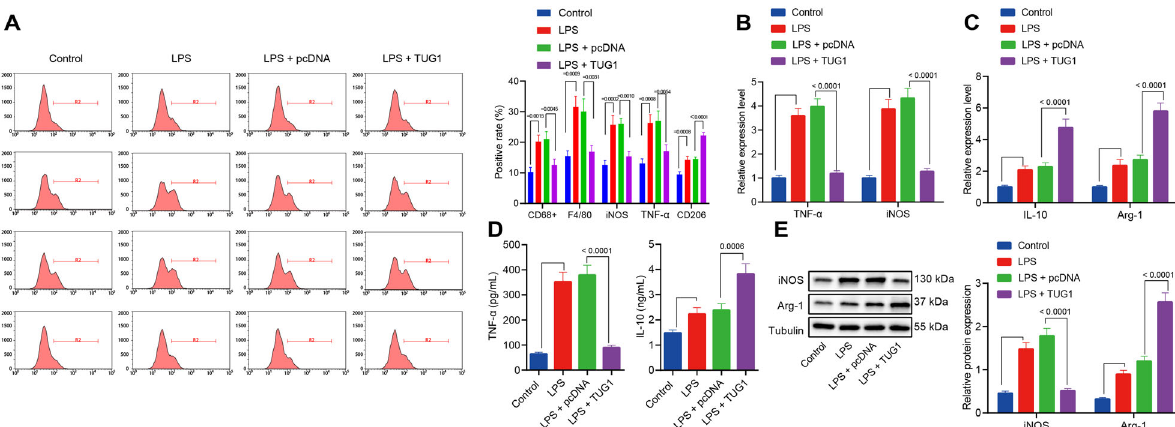
Fig. 2 TUG1 induces macrophage polarization into an anti-in fl ammatory M2 state. A The number of CD68 + and F4/80 + macrophages assessed by fl ow cytometry and percentages of M1 markers iNOS and TNF- α as well as M2 marker CD206 in a single-cell suspensions of whole lung tissue from the mice ( n = 12). B The mRNA expression of M1 markers iNOS and TNF- α in macrophages treated with LPS determined by RT-qPCR. C RT-qPCR for determination of mRNA expression of M2 markers IL-10 and Arg-1 in macrophages treated with LPS. D The contents of IL-10 and TNF- α protein in medium examined by ELISA. E The protein expression of M1 markers iNOS and Arg-1 in macrophages treated with LPS measured by western blot analysis. Measurement data were expressed as mean ± standard deviation. One-way ANOVA was adopted for comparison between multiple groups followed by the Tukey ’ s post hoc test. Cell experiments were conducted three times independently. * p < 0.05 vs. control macrophages; # p < 0.05 vs. LPS-induced macrophages treated with